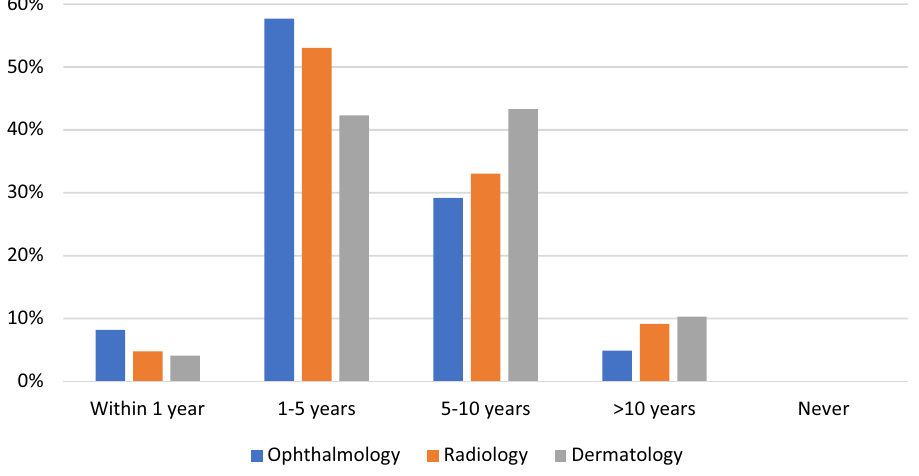
Figure 4. Perceived length of time before artificial intelligence has a noticeable impact on [your specialty].